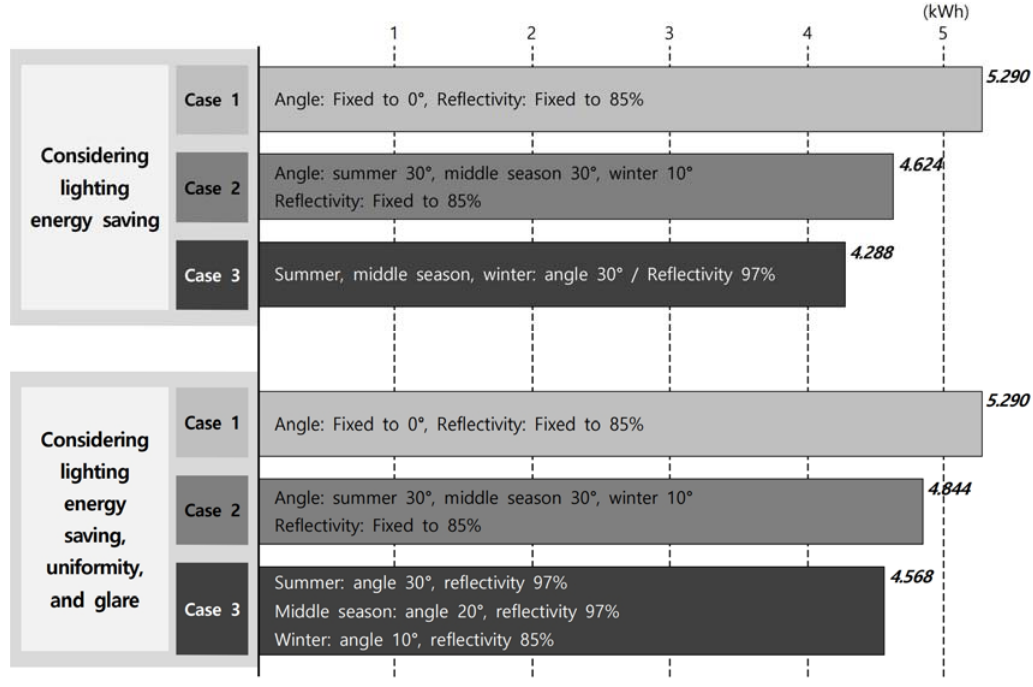
Figure 12. Performance evaluation results by case: total lighting energy usage.